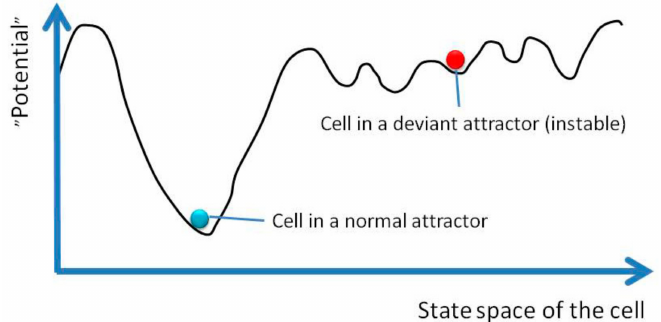
Figure 4. Schematic representation of cells in normal and variant attractors in one-dimensional projection of the state